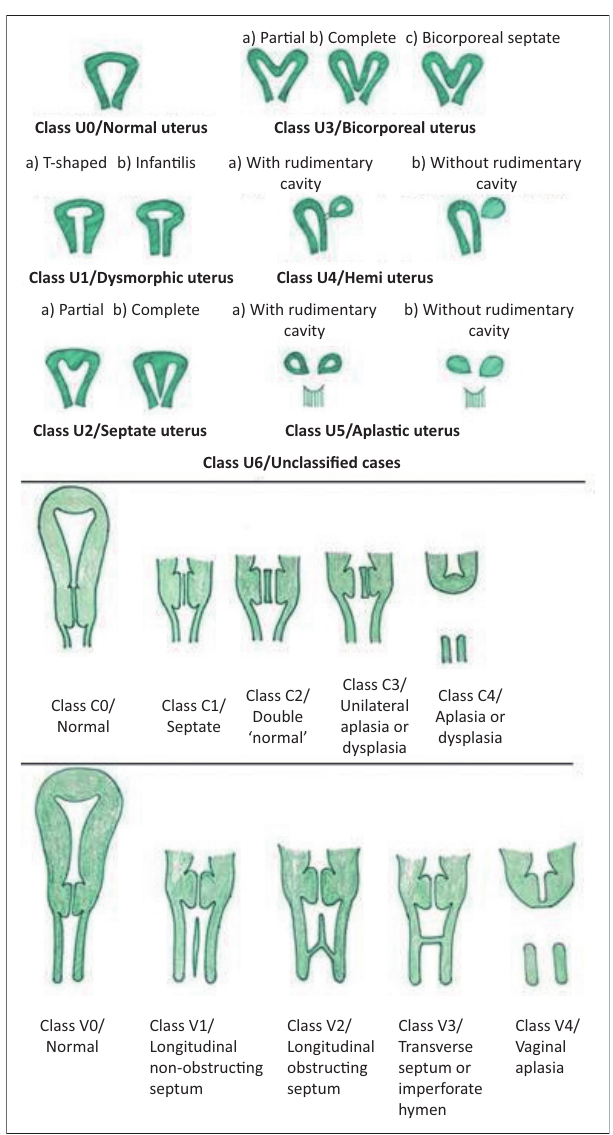
FIGURE 6: The European Society of Human Reproduction and Embryology and the European Society for Gynecological Endoscopy classification.